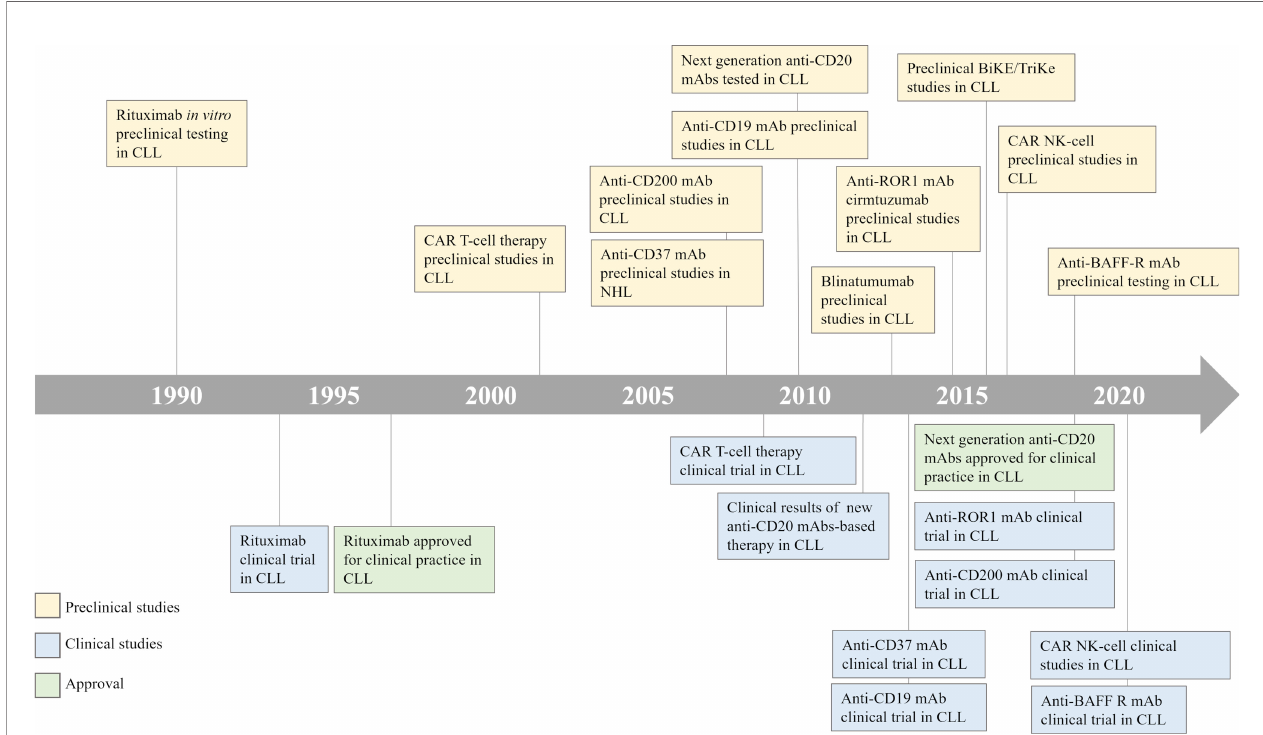
FIGURE 1 | CLL treatment timeline. A timeline illustrates the development of immune-based therapeutic strategies for the treatment of patients with CLL. CLL, Chronic Lymphocytic Leukemia; CAR, Chimeric Antigen Receptor; NHL, Non-Hodgkin Lymphoma; BiKE/TriKE, Bispeci fi c/Trispeci fi c Speci fi c Killer Engagers; NK, Natural